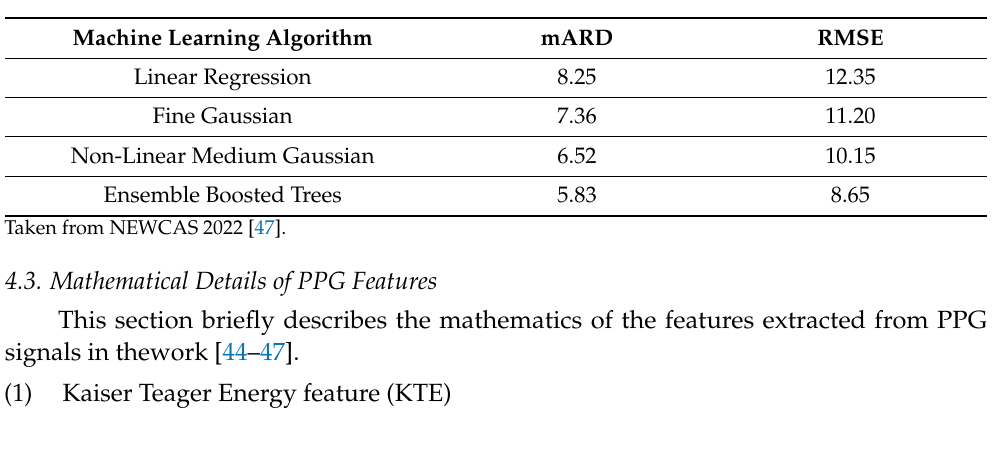
Table 1. Different feature set performance with four machine learning algorithms. Combination of Features